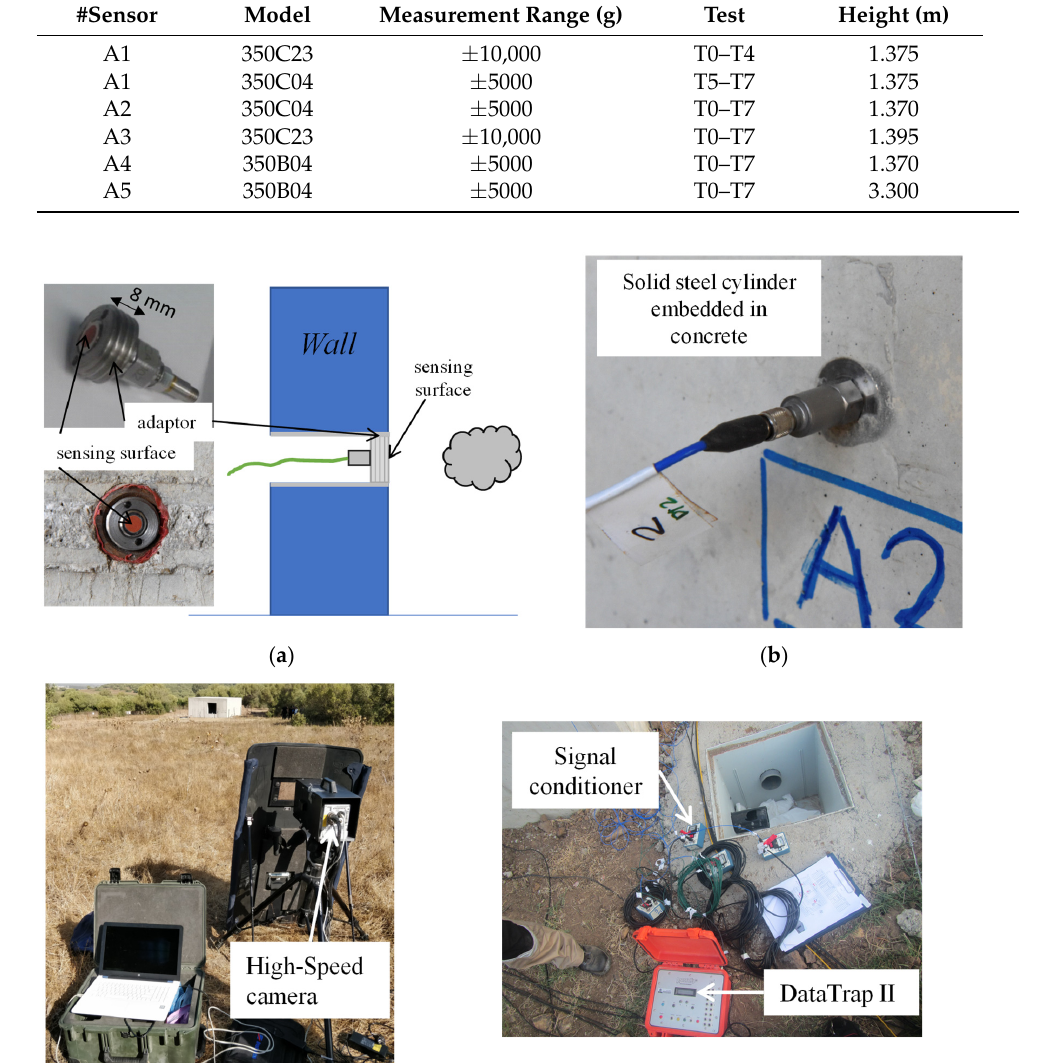
Table 2. Characteristics of the accelerometers used and the height at which they were positioned.